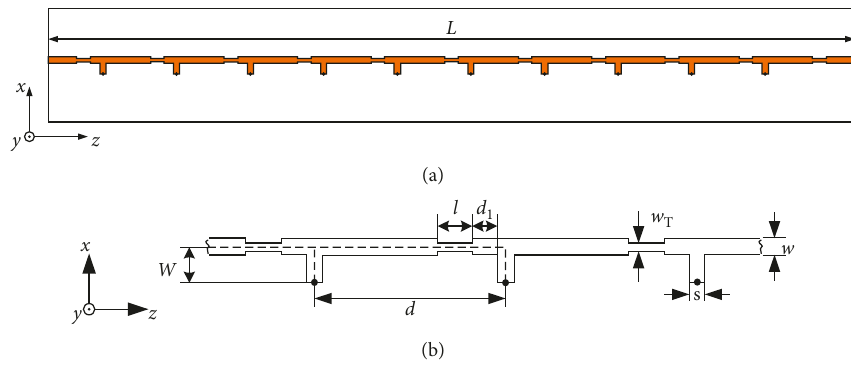
Figure 1: The proposed miniaturized periodic microstrip leaky wave antenna with shorting pins. (a) Top view; (b) detail view.